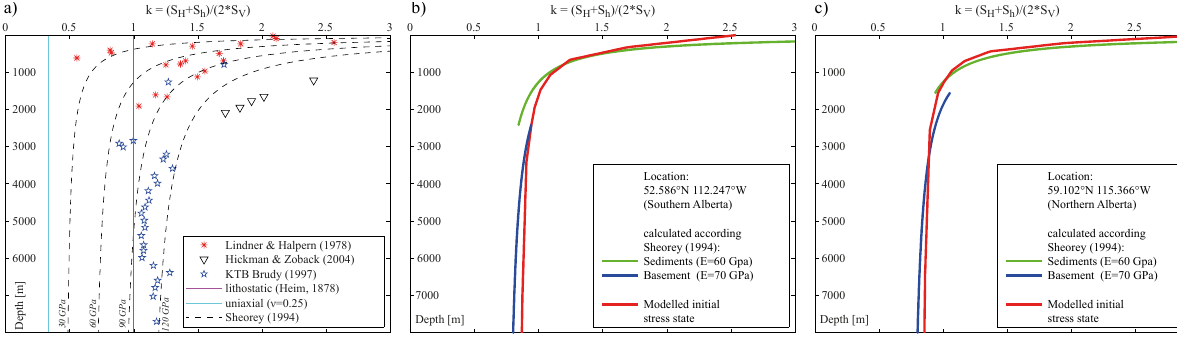
Figure 9. (a) Compilation of k ratios from North America (Lindner and Halpern, 1978), the SAFOD pilot hole (Hickman and Zoback, 2004) and from the KTB (Brudy et al., 1997). Theoretical k ratios based on the assumption of lithostatic load at greater depths (Heim, 1878, k = 1), uniaxial strain conditions (Eq. 2) and the distribution according to Sheorey (1994, Eq. 5) for Young’s modulus E = 30, 60, 90 and 120GPa are plotted. (b) and (c) Depth profile of the initial and calculated k values for two test sites within the model. Blue and green lines indicate calculated k profiles based on Sheorey (1994, Eq. 5) and the associated Young’s modulus. The red line indicates the k profiles from the model with the initial stress state.